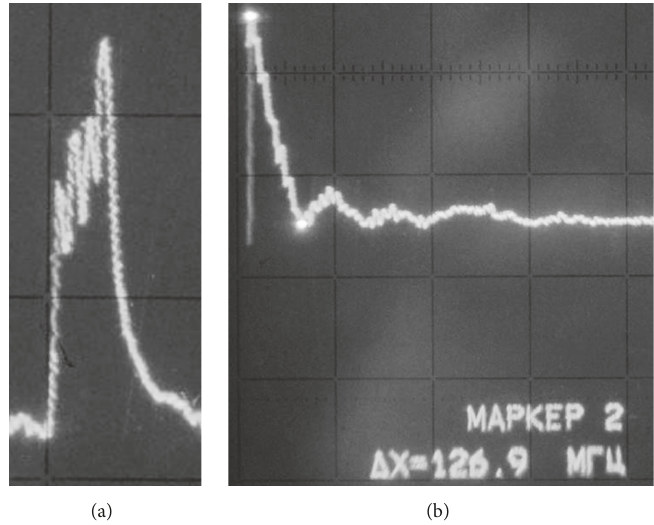
Figure 16: The waveform (a) and the spectrum (b) of the signal at the far end of a structure with a wire break.